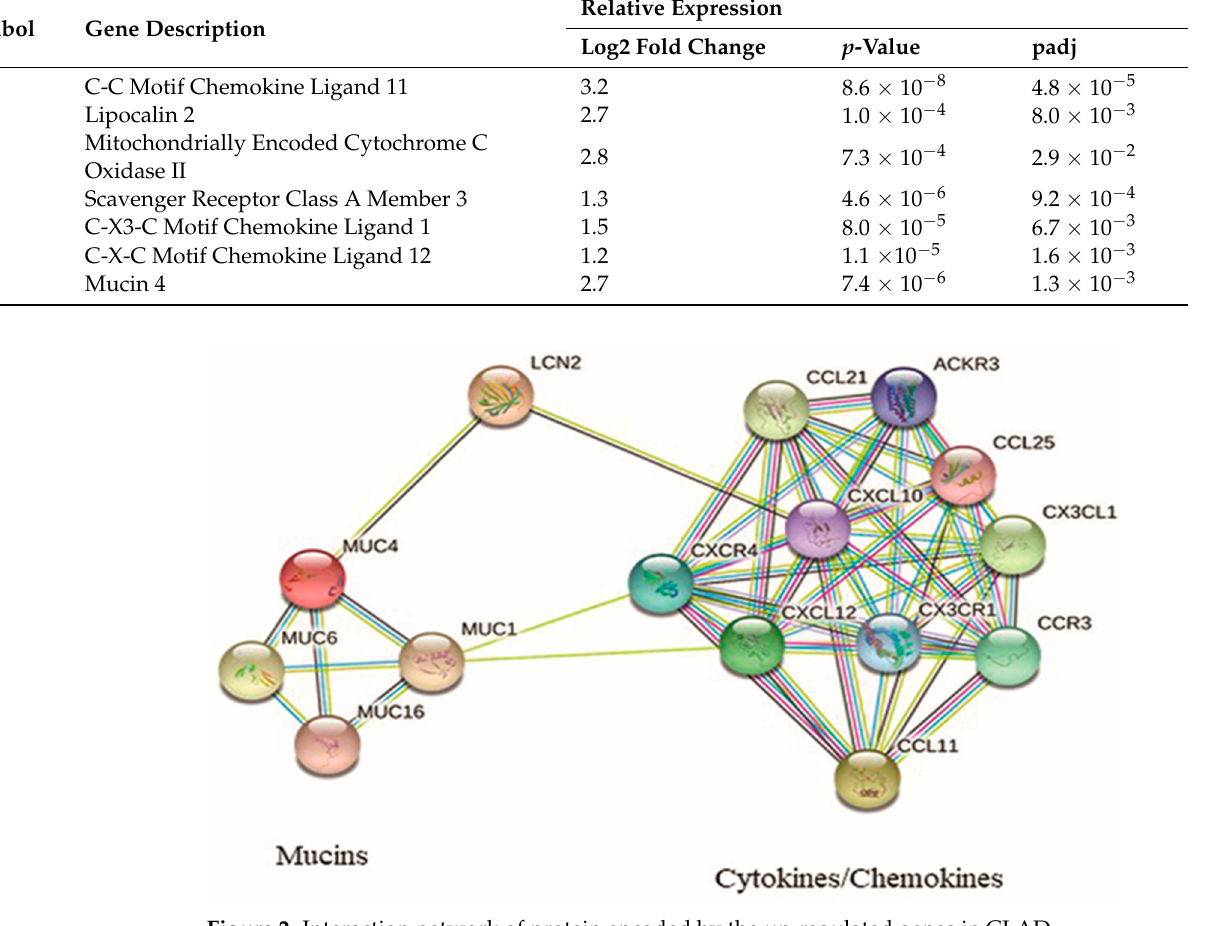
Figure 2. Interaction network of protein encoded by the up-regulated genes in CLAD.